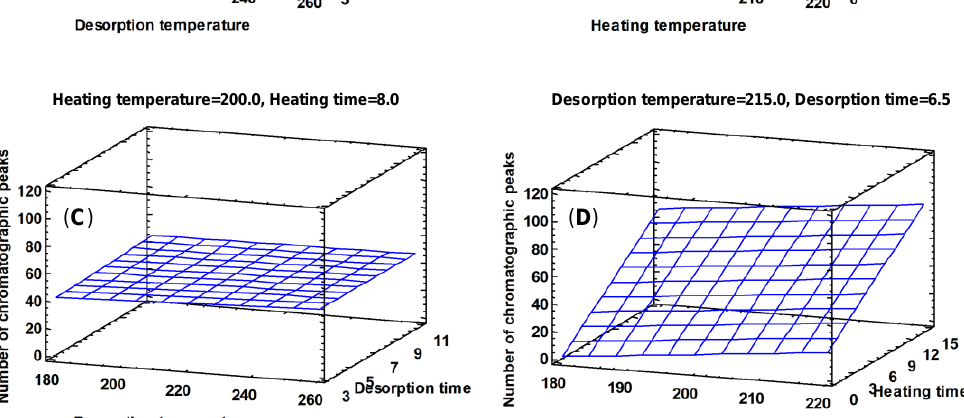
Figure 2. Interaction heating time–heating temperature. Estimated response surface for total chromatographic area ( A ) and for the number of chromatographic peaks ( C ). Interaction desorption time–desorption temperature. Estimated response surface for total chromatographic area ( B ) and for the number of chromatographic peaks ( D ).